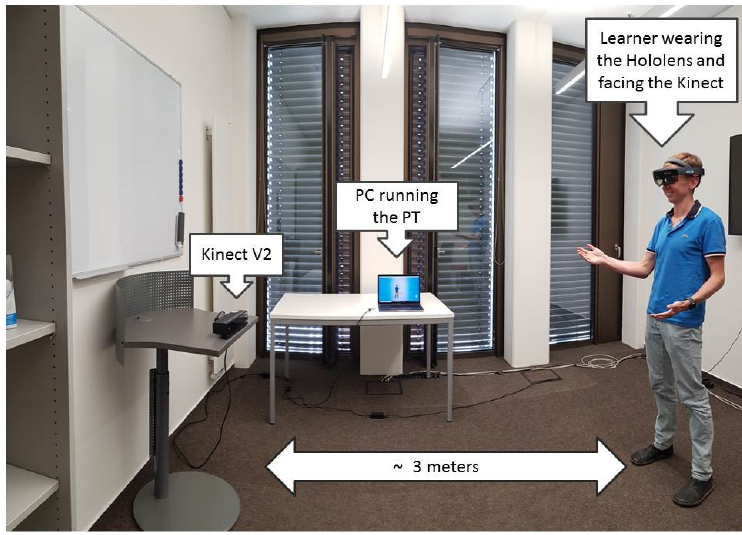
Figure 5. Picture of the experimental setup. Learner practicing an Elevator Pitch standing in front of the Kinect and Wearing the Hololens.